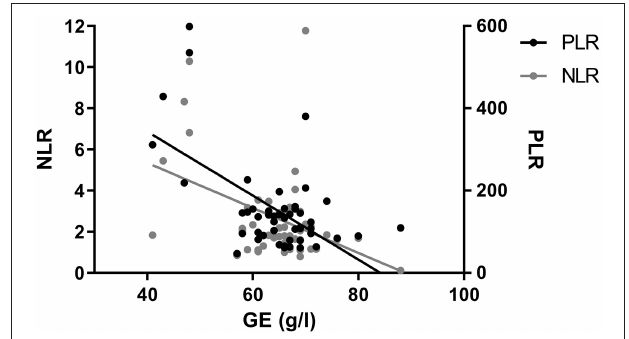
FIGURE 5 | Correlation of neutrophil-to-lymphocyte ratio (NLR) and platelet-to-lymphocyte ratio (PLR) with total protein (TP) concentration. NLR and PLR correlate significantly with total protein ( p < 0.0001 and p < 0.0001) at 6-month MRI.